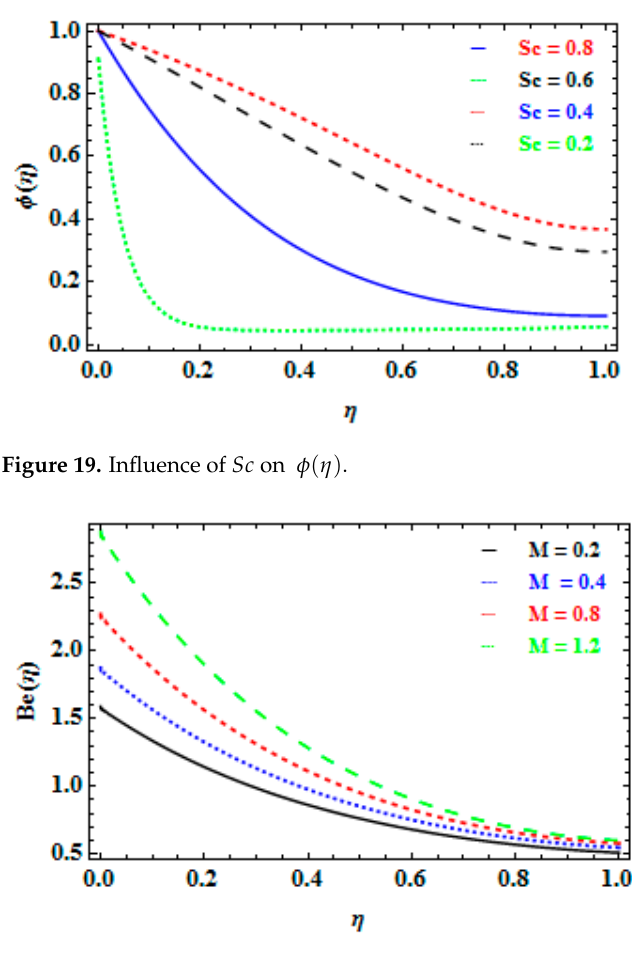
Figure 21. Influence of Br on 𝐵𝑒 ( 𝜂 ) . Figure 22. Influence of P r on 𝑁 (cid:3008) ( 𝜂 ) .